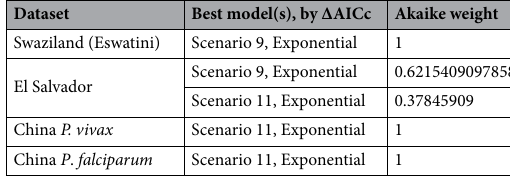
Table 2. Summary of ΔAICc